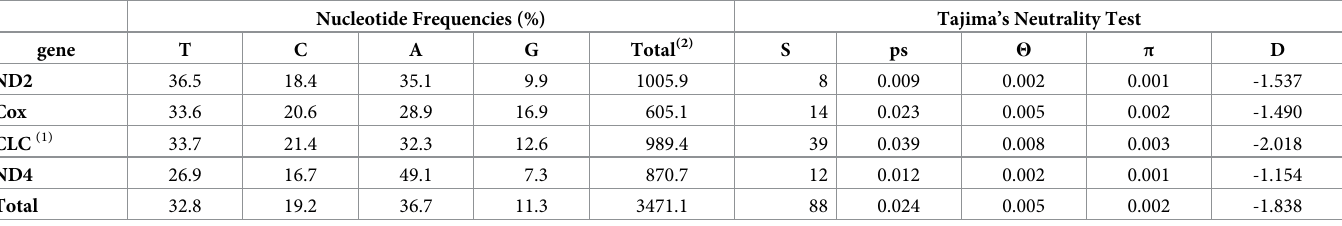
Table 3. Nucleotide frequencies and polymorphisms in Bactrocera oleae (S = number of segregating sites, ps = S/m, Θ = ps/a1, π = nucleotide diversity, and D is the Tajima test statistic). Nucleotide Frequencies